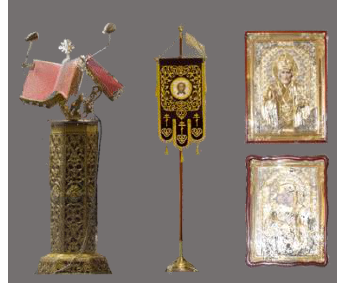
Figure 5 . Examples of furniture represented as point